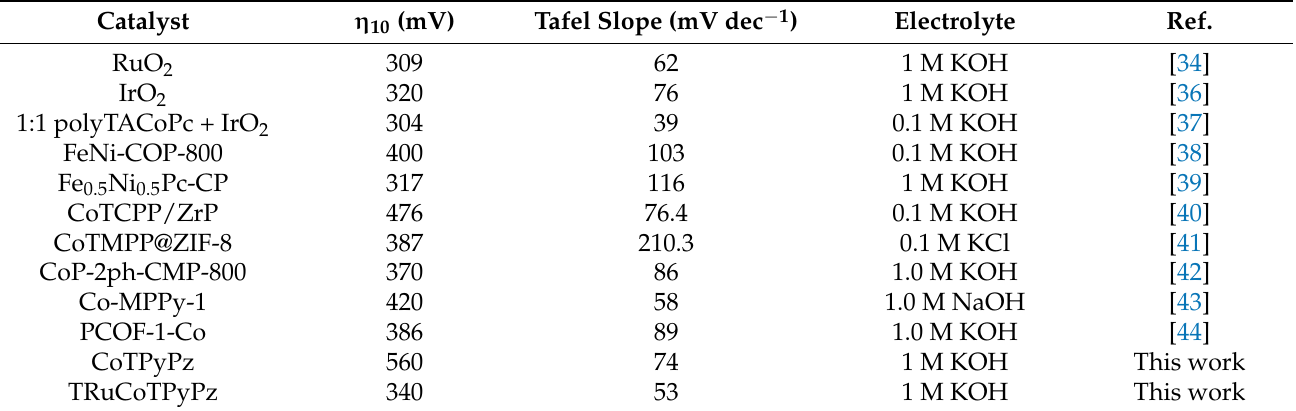
Table 1. Comparison of the electrochemical parameters of some OER